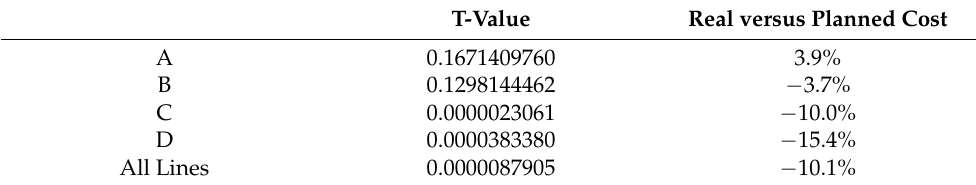
Table 11. Results of the t -test for the comparison of planned and real costs.